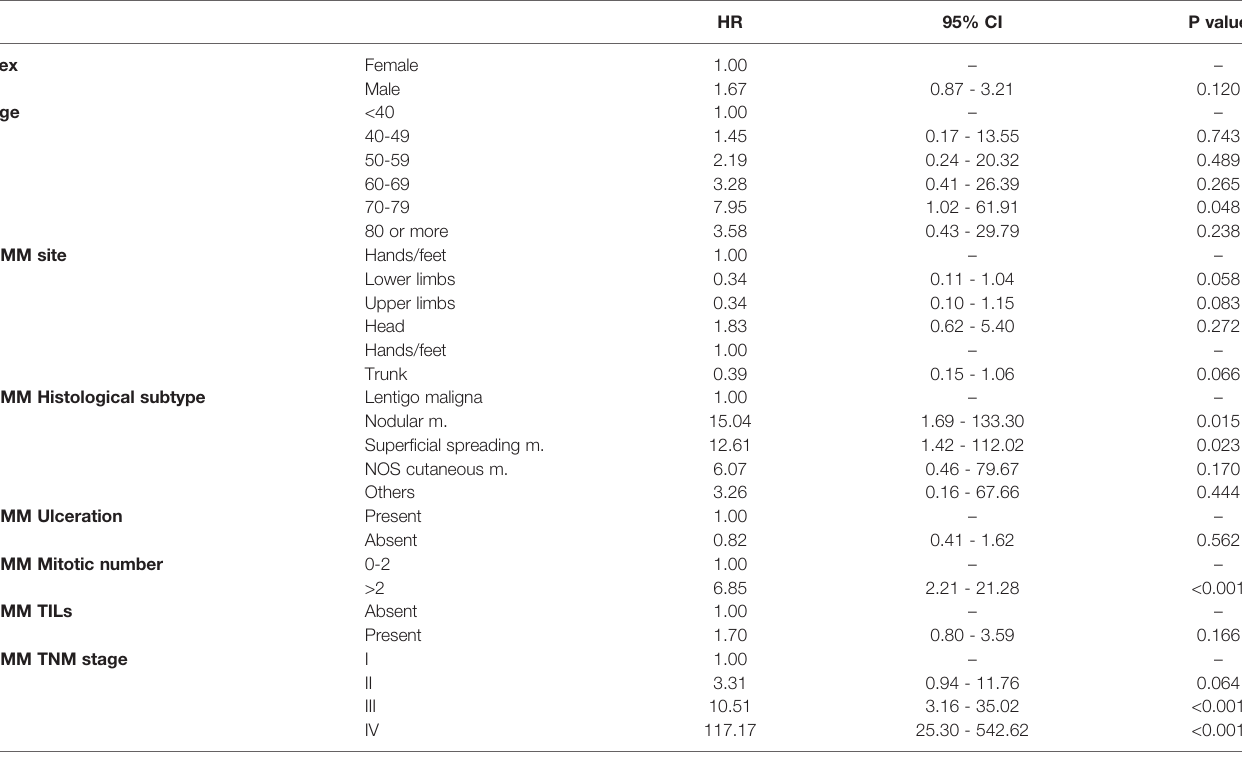
CMM, cutaneous melanoma; NOS, not otherwise speci fi ed; TILs, tumor in fi ltrating lymphocytes; m, melanoma. HR, hazard ratio; Assumption of proportionality: p-value 0.577.